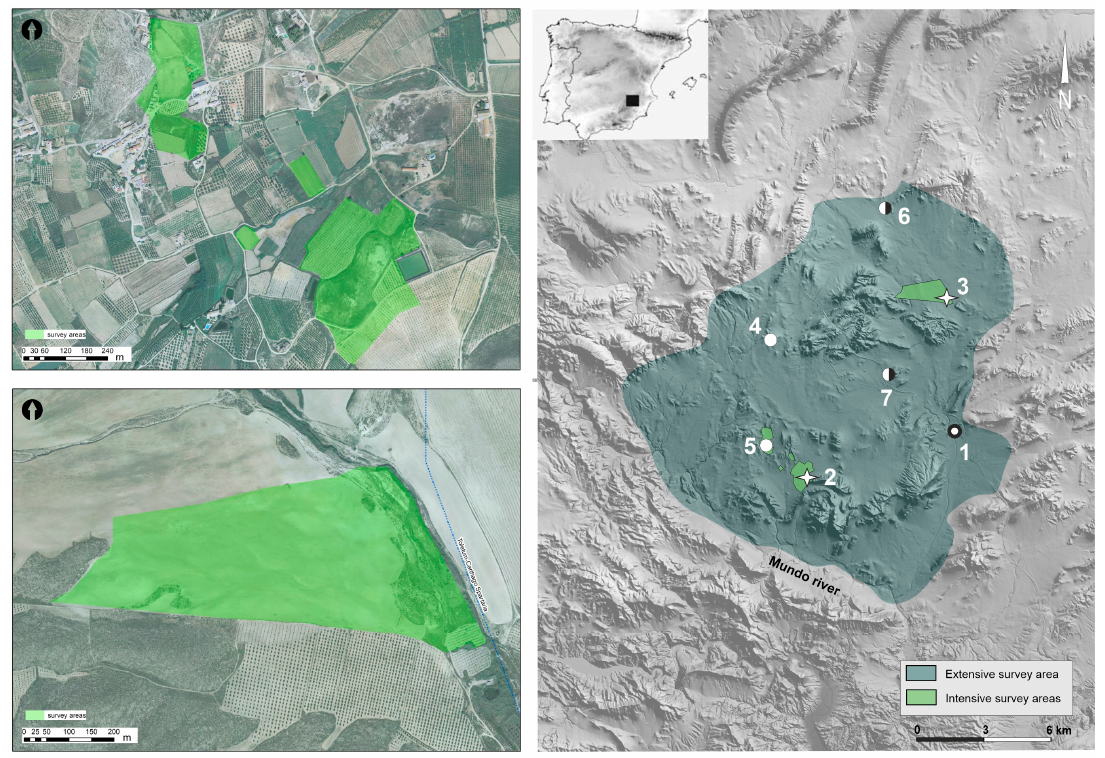
Figure 3. The surveyed areas in “Campos de Hellín” ( left ) and the main archaeological sites identified by the extensive surveys and some excavations ( right ): (1) Eio / Iyyuh city (TM); (2) Visigothic village of Loma Eugenia; (3) Visigothic village of Loma Lencina; (4) Roman villa of Hellín; (5) Roman villa of Agra; (6) Late Antiquity castrum of Alboraj; (7) Late Antiquity castrum of Torre Uchea.